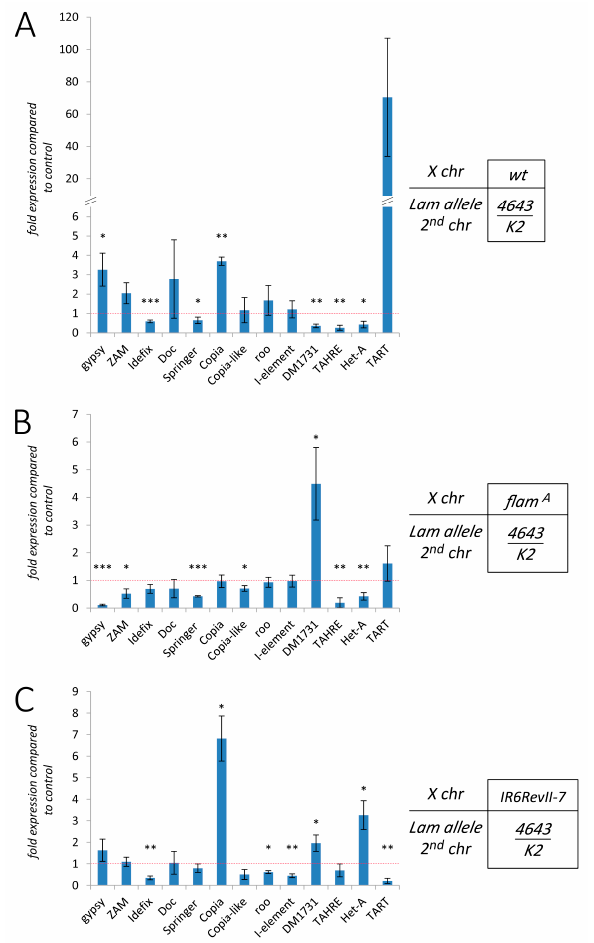
Figure 4. Expression variations of families of TEs in somatic tissues of Lam mutants with di ff erent genetic backgrounds. ( A – C ) qRT-PCR analysis of a number of retrotransposons in RNAs isolated from female head tissues. Histograms indicate the expression level of each TE in Lam mutants (4643 / K2) compared to that of the specific control ( +/+ ). Data are mean values from three independent experiments, and error bars indicate SD (* P < 0.05; ** P < 0.01; *** P < 0.005). Expression levels in: Canton S genetic background ( A ); flam A genetic background ( B ); w IR6RevII7 genetic background ( C